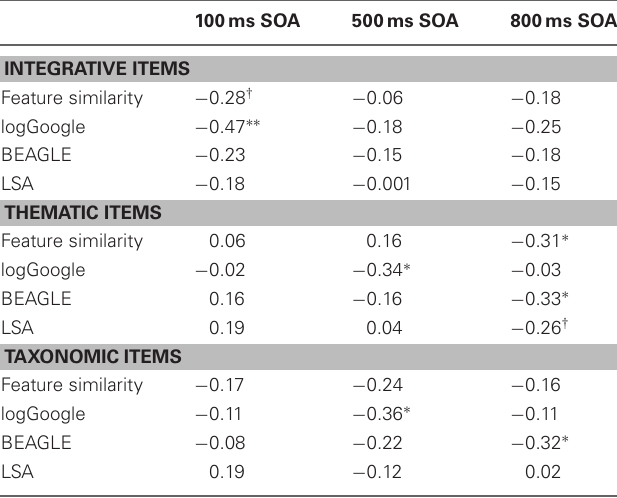
Table 7 | Study 4, partial correlations—predictors of target response times (ms) by